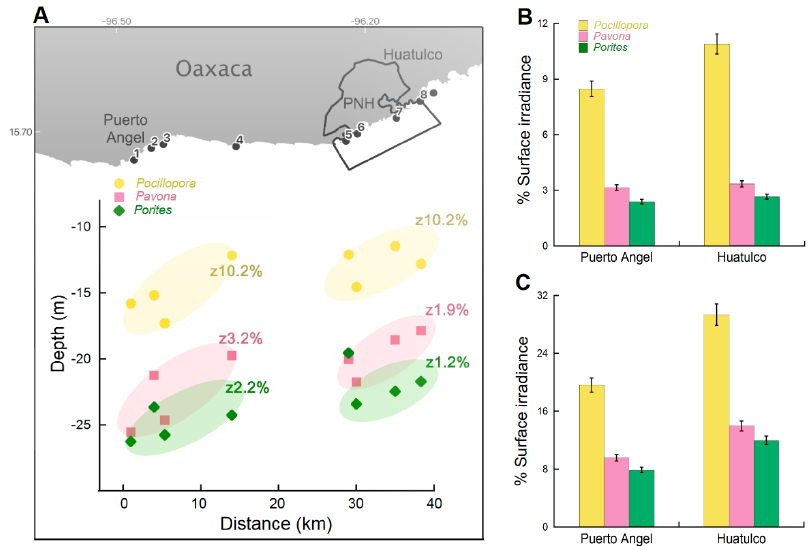
Figure 2. ( A ) Maximum depths of coral genera recorded for each site of Puerto Ángel and Huatulco and their average value for the percentage of surface light at each depth (zEs%). The plot also illustrates the distance (km) between sites, where 0 km is the reference for Puerto Ángel bay, located in the west. On the opposite side, in a straight line, is located, at 40 km, La Blanca Islet, outside of the Huatulco protected natural area (PNH). Numbers given with the locations are the same as in Figure 1; ( B ) variation of the percentage of surface irradiance, %Es (monthly averaged) at the maximum depths recorded for coral distribution during the upwelling season; and ( C ) the no-upwelling months.